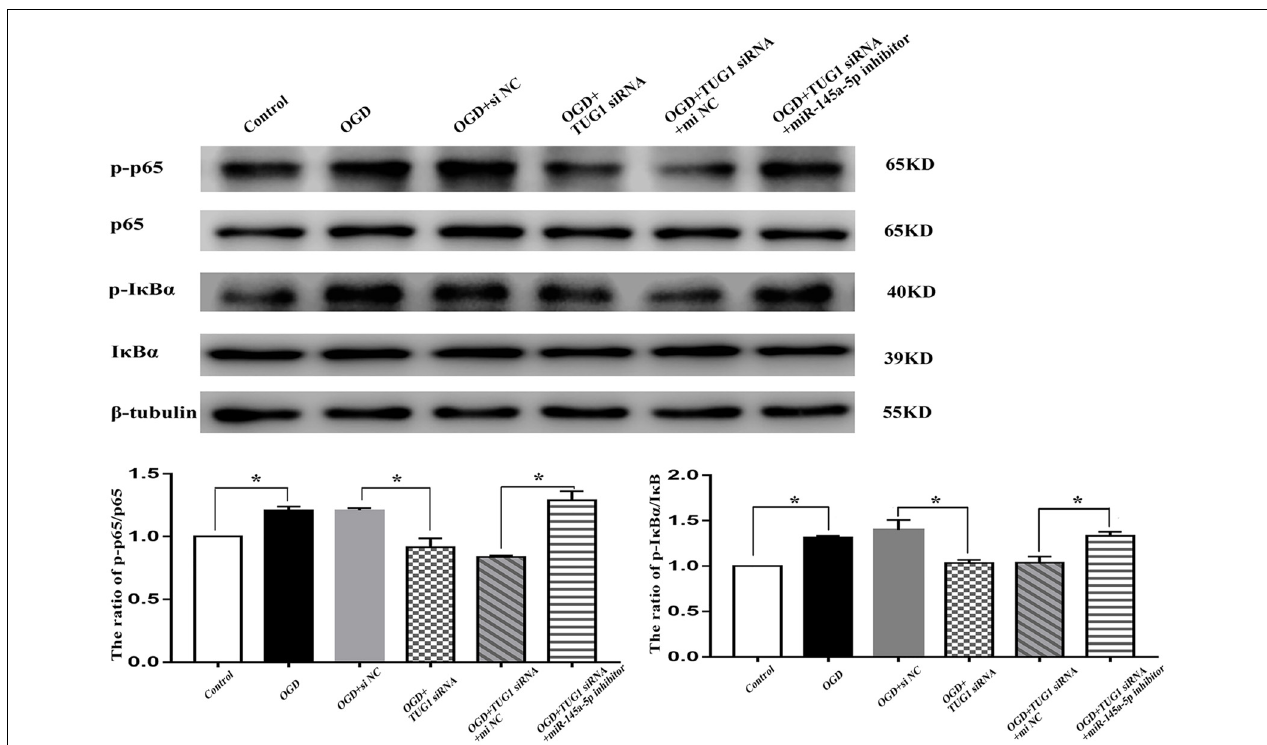
FIGURE 5 | NF- κ B activity by western blot analysis. OGD-induced NF- κ B activation was inhibited by TUG1 knockdown, represented by the decreased ratios of p-p65/p65 and p-I κ B α /I κ B α proteins. The effect of TUG1 knockdown was reversed by miR-145a-5p inhibitor. ∗ P < 0.05 vs. the corresponding control. n =